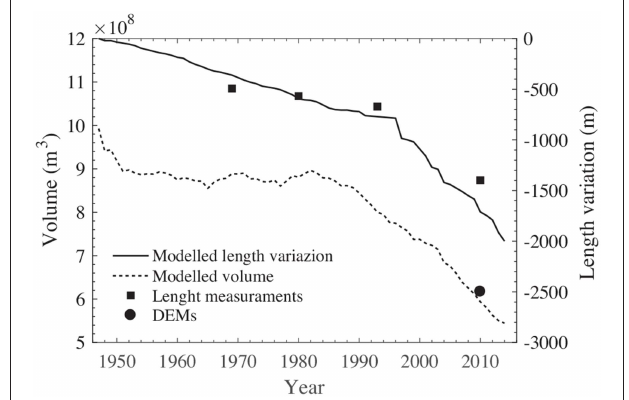
FIGURE 4 | Modeled glacier length and volume change of Gauligletscher between 1947 and 2014 (black lines) compared with observed length (black squares) and volume inferred from the DEM of 2010 (black dots). The glacier length is relative to the extent in 1947.